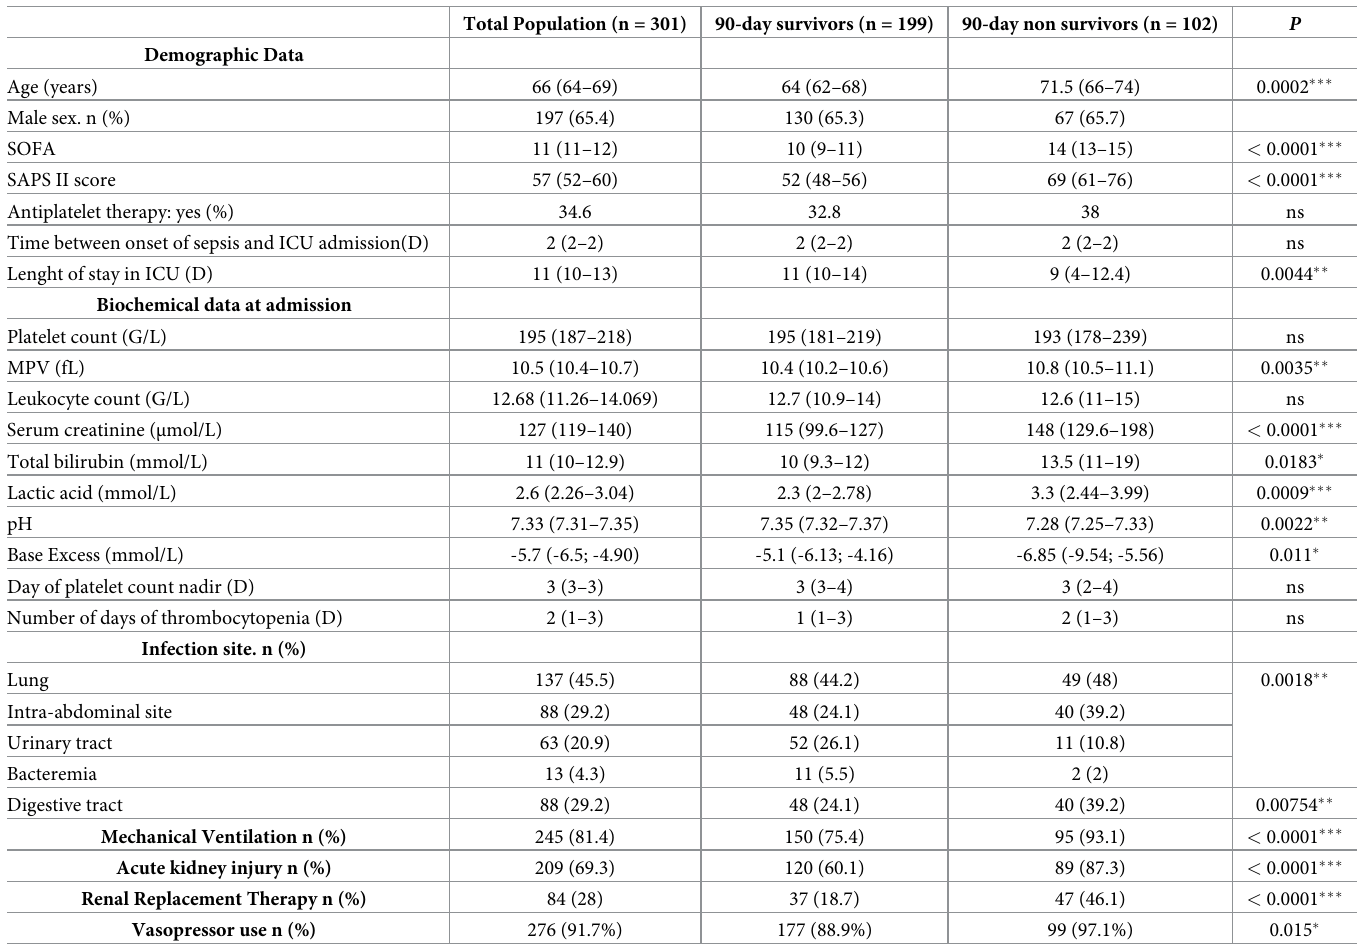
Table 1. Characteristics of the